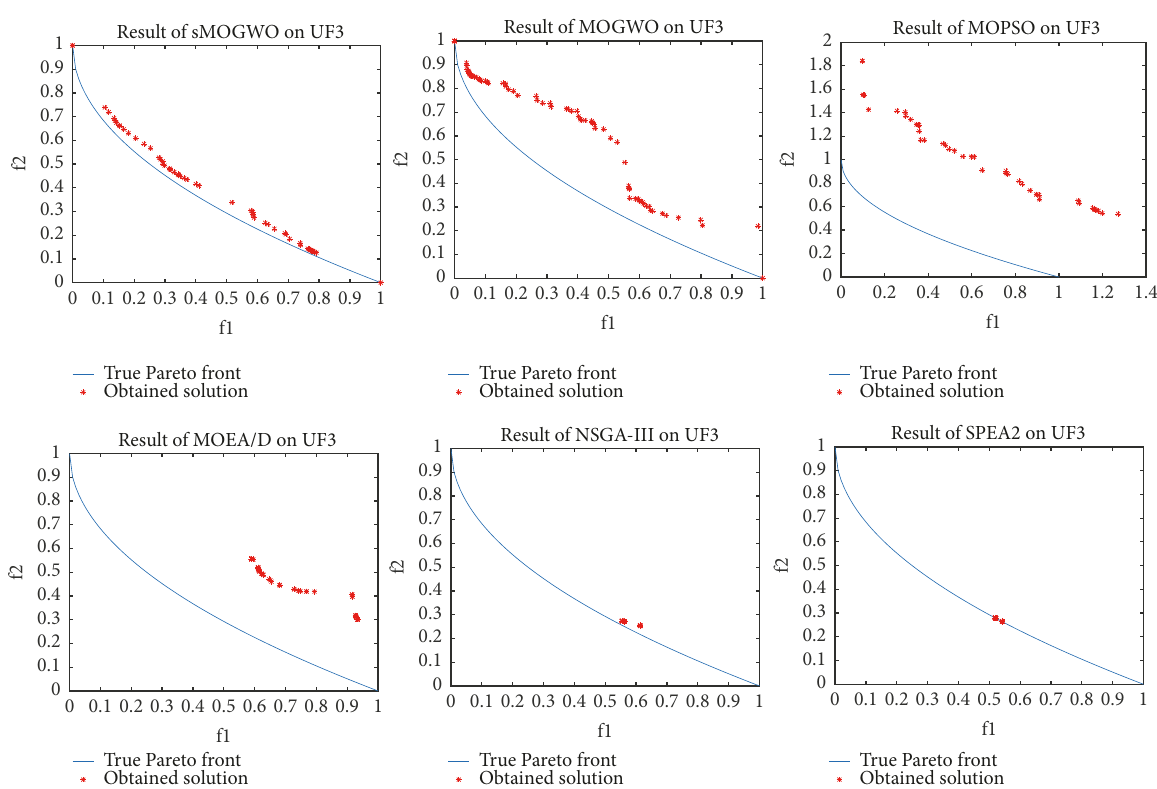
Figure 7: The best optimal results of the different algorithms in repeated experiments on UF3.